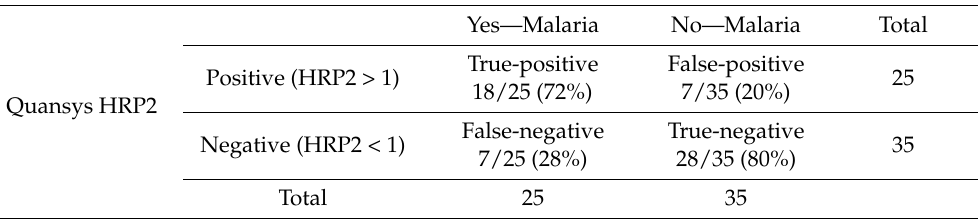
Table 6. Accuracy of the HRP2 biomarker measured on the Quansys ELISA to identify Burkina Faso children with